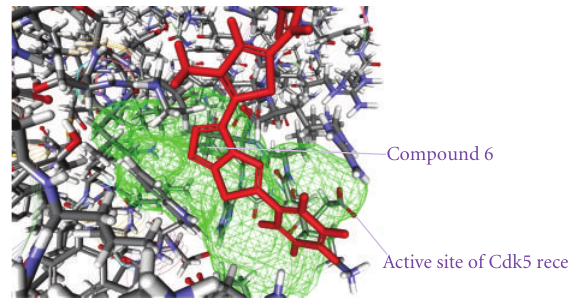
Figure 7: The docked conformation of compound 6 with the receptor CDK5/p25 (PDB: 3O0G). Compound 6 is indicated by red color while the most active site of the CDK5 receptor is shown with green